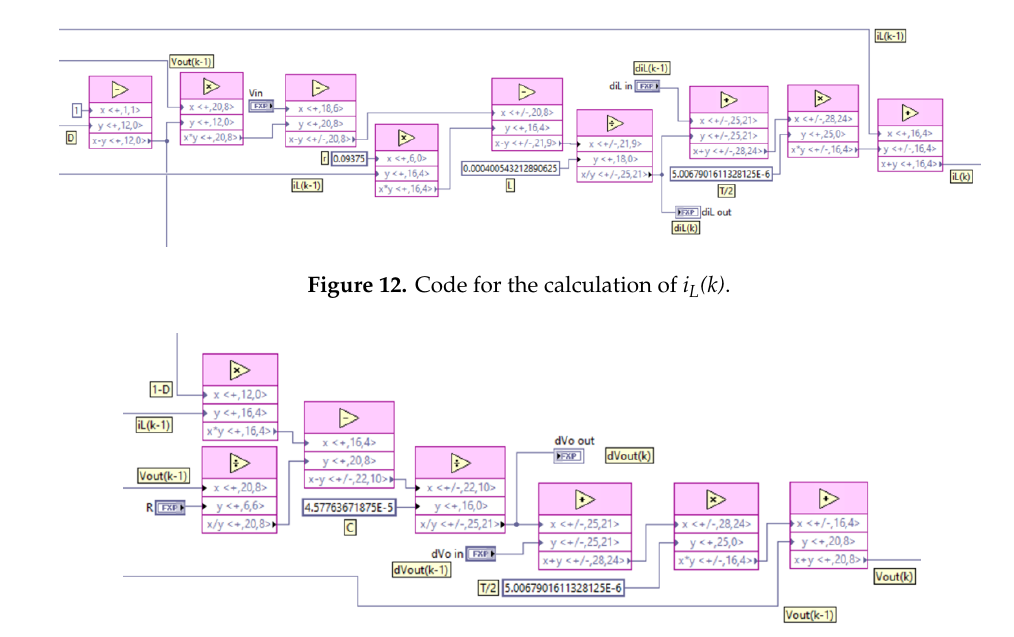
Figure 13. Code for the calculation of V out (k) .